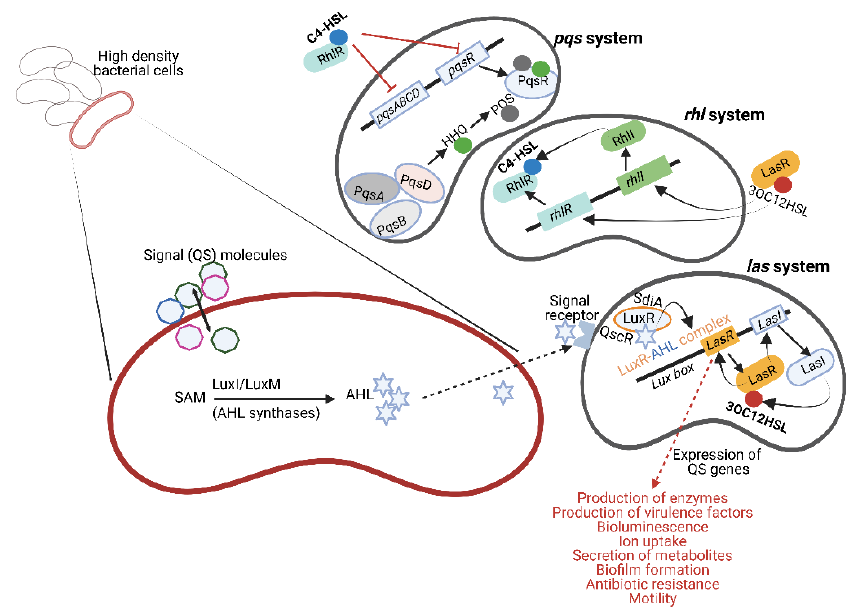
74 Figure 1. Quorum sensing (QS) molecules produced by Gram-negative bacteria. Acyl-homoserine